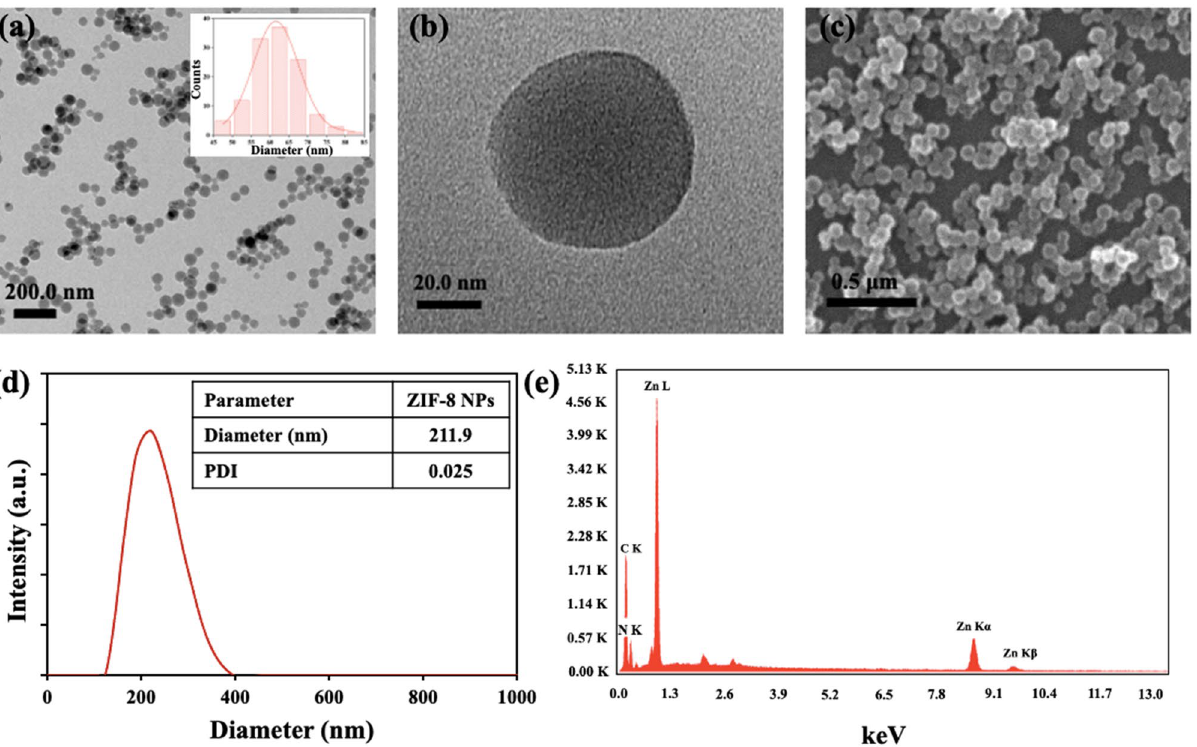
Figure 1. ( a , b ) TEM images of ZIF-8 NPs at a scale of ( a ) 200.0 nm and ( b ) 20.0 nm. ( c ) SEM image of ZIF-8 NPs. ( d ) DLS plot. ( e ) EDS plot confirming the elemental composition of ZIF-8